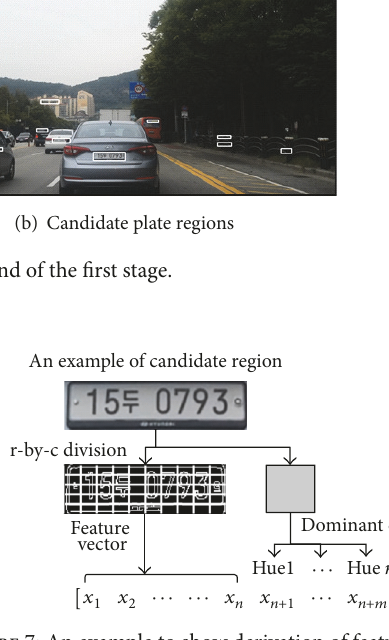
Figure 7: An example to show derivation of feature